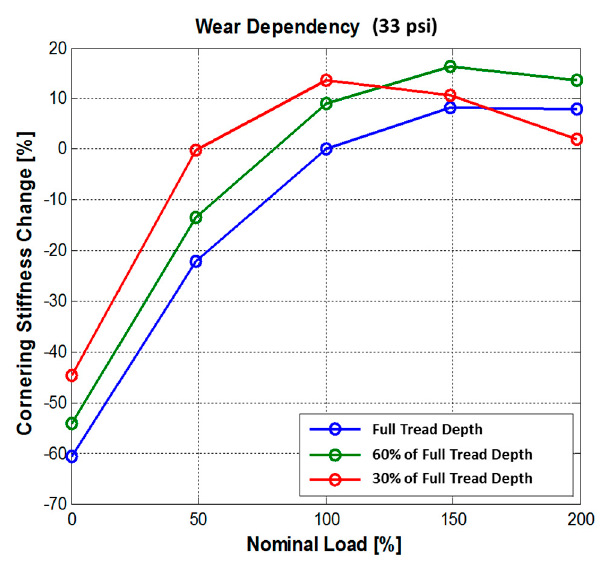
Figure 12. Wear dependency effects under constant inflation pressure conditions.